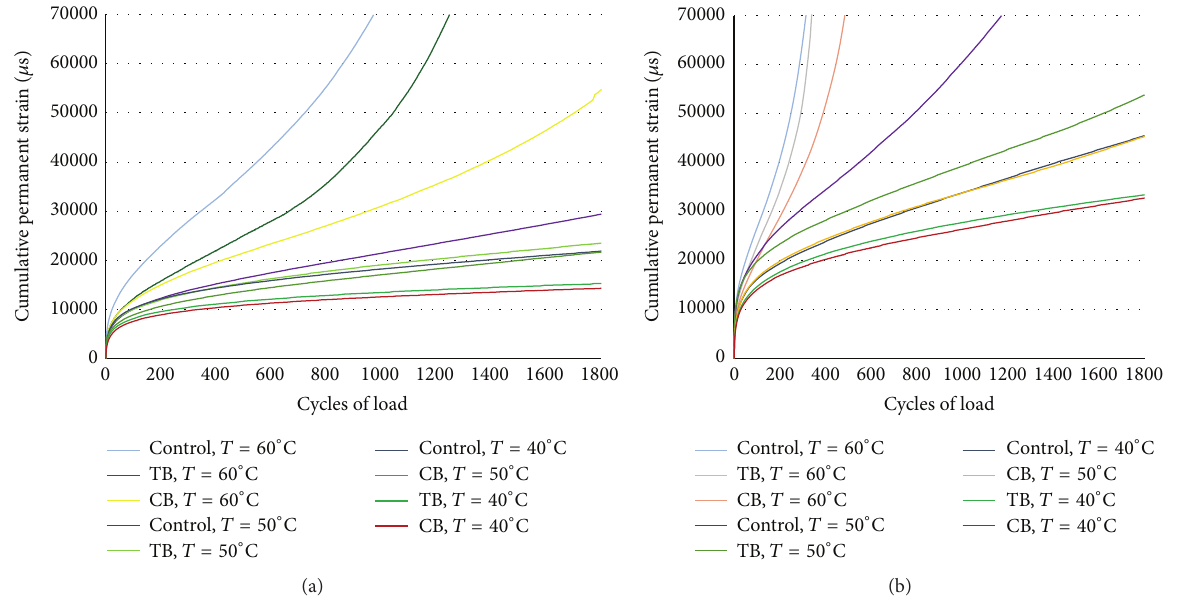
Figure 5: (a) Creep curve for control and rubberized asphalt mixtures at different temperatures tested at 200kPa. (b) Creep curve for control and rubberized asphalt mixtures at different temperatures tested at 400